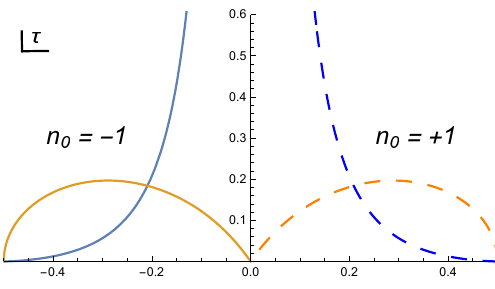
Figure 3 . The orange curves are plots of extremal curves (cid:28) (cid:3) . The blue curves are plots of their entropy as a function of the worldline parameter (cid:28) 1 . These curves agree with the respective gravitational curves with the same labels. In the gravitational theory the extremal curves for n 0 = (cid:0) 1 (solid) and for n 0 = +1 (dashed) have the same metric and gauge (cid:12)eld con(cid:12)gurations.